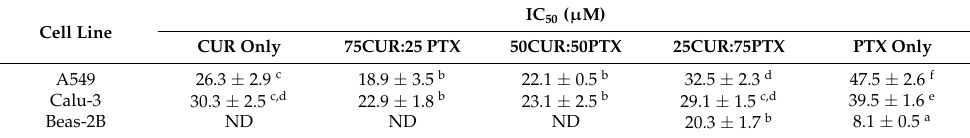
Table 3. IC 50 values of single and combination formulations assayed using MTS cytotoxicity.